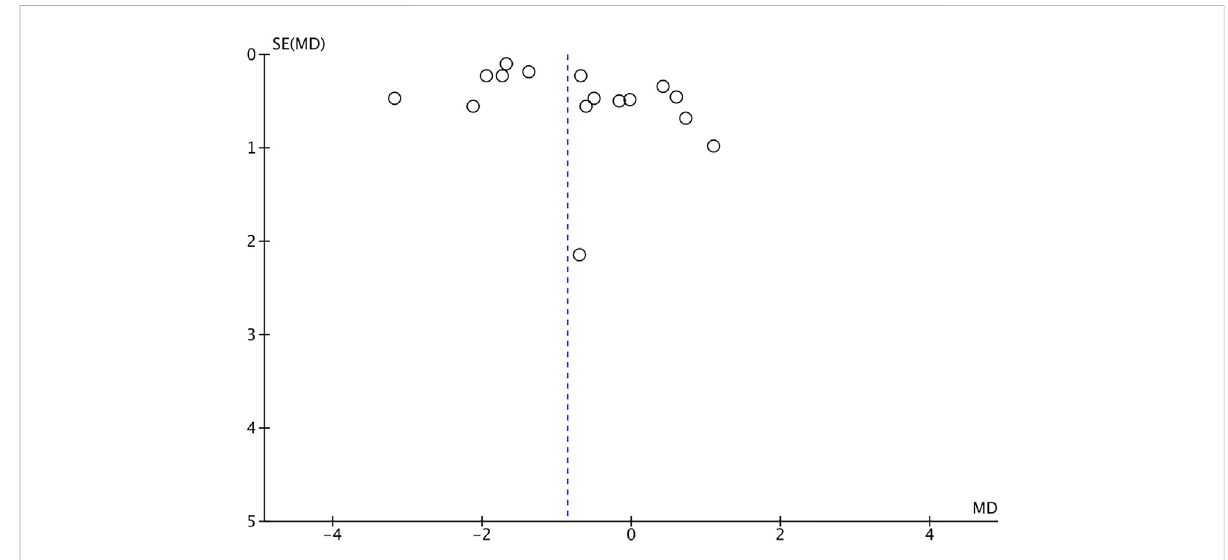
FIGURE 4 Risk of publication bias of included studies. SE, standard error; MD, mean deviation.